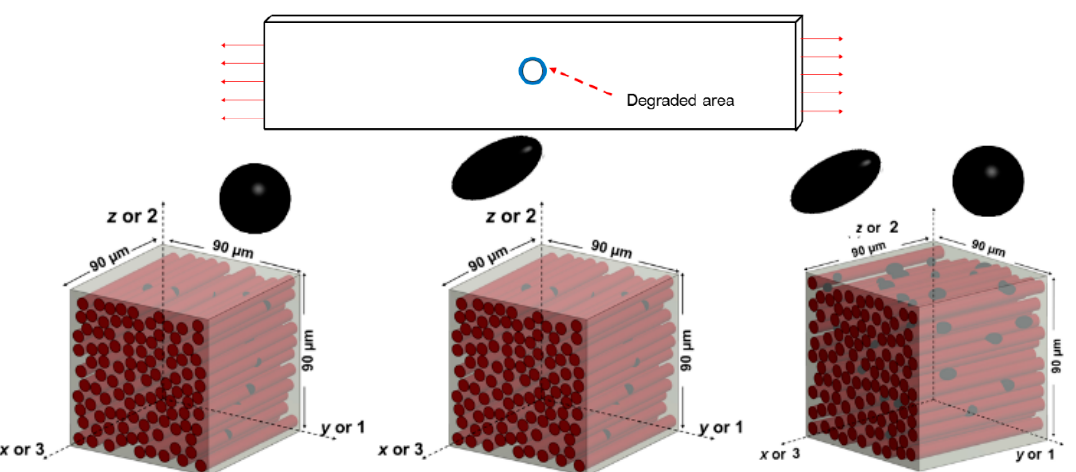
832 Figure 9. Comparison of failure loads of Peridynamic (PD) simulations and experiments. 3.4. Quantifying the Strength of the UD Plate with One Hole in the Presence of Microvoid (Effect of Microscale Defects) Making holes in composite materials may cause material degradation at the vicinity of their edges. Consideration of the degraded material properties around the hole edges is necessary to predict the strength of unidirectional composite plates with an open hole accurately. To fulfill this requirement, the bond constant for the degraded area must be updated. This can be performed by quantifying the local material properties degradation